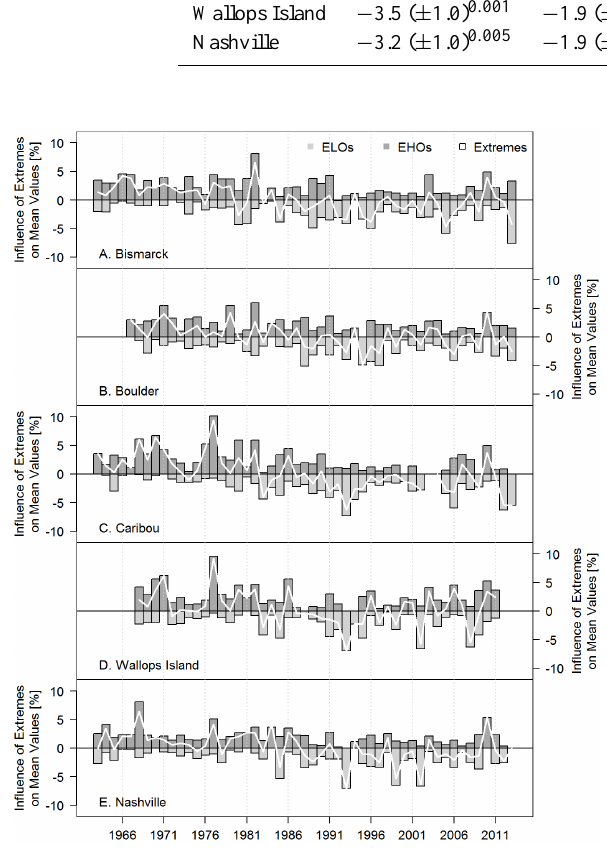
Figure 8. Influence (in %) of events of extremely low (ELOs, light histogram) and high (EHOs, dark histogram) ozone and net influ- ence of extremes (white curve) on winter (DJF) mean ozone at (a) Bismarck, (b) Boulder, (c) Caribou, (d) Wallops Island, and (e) Nashville.